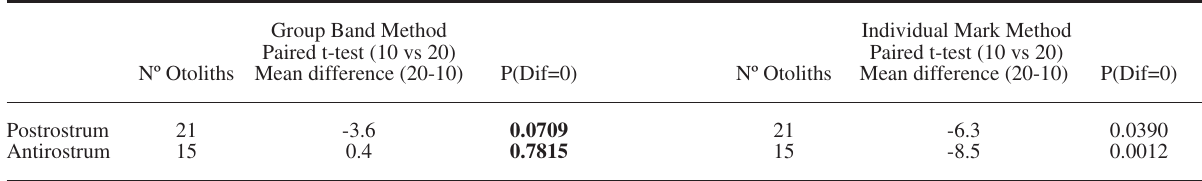
Table 2. – Comparision of the amplification effects on the different age reading methods for the two sagittal axes, checked by paired t test (two tailed) on individual otolith age determinations.